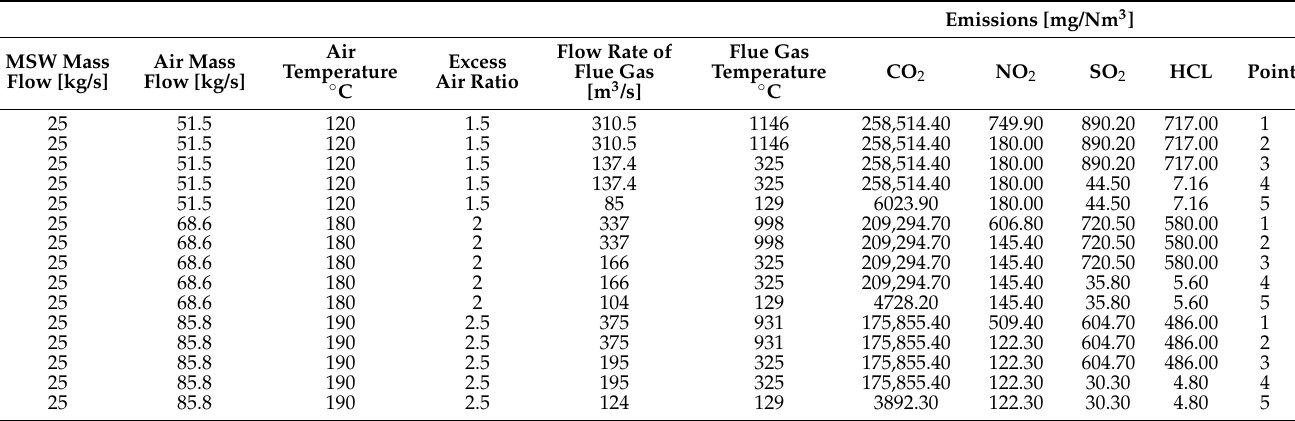
Figure 8. Flue gas cleaning system for the proposed incineration facility (simulated in Ebsilon). Table 14. Results of the simulated flue gas cleaning emissions system for 25 kg/s of